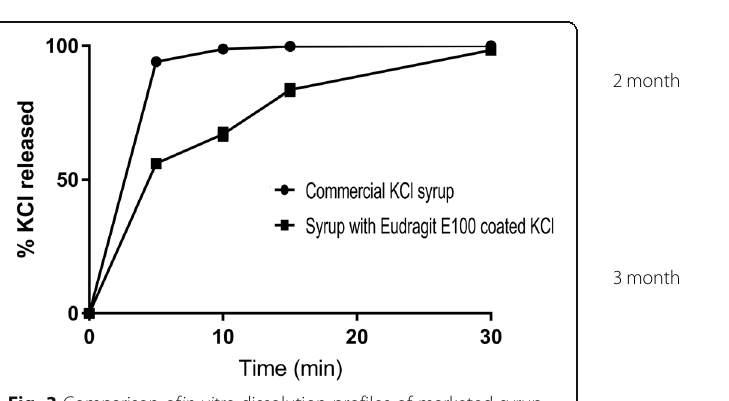
Fig. 3 Comparison of in vitro dissolution profiles of marketed syrup formulation and reconstituted formulation F8. The observations are average ± standard deviation of n = 6 (The error bars are not visible in the figure owing to standard deviation values less than 2)